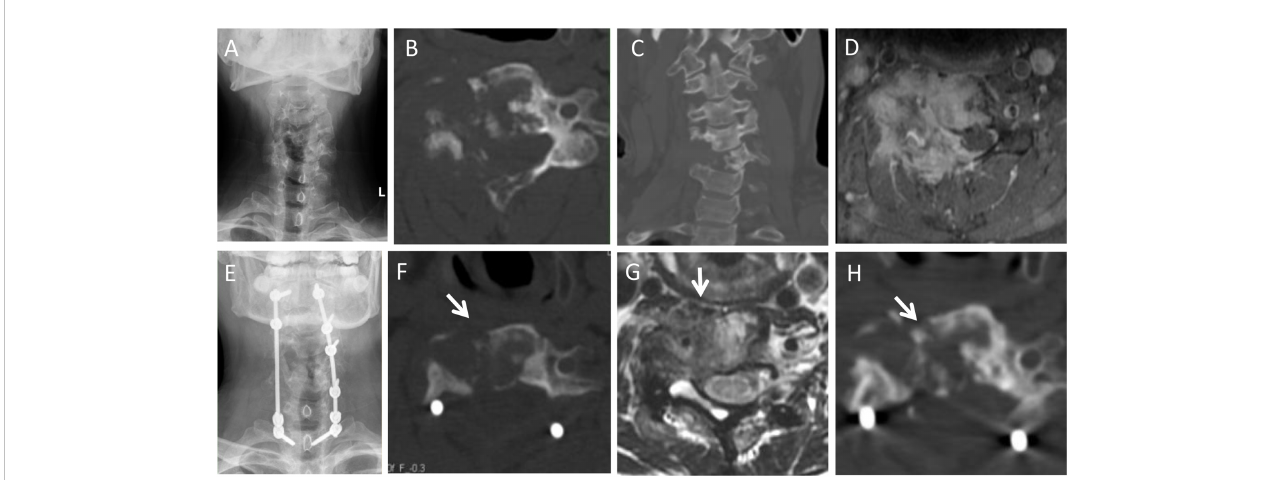
FIGURE 4 A 28-year-old male with neck pain for 12 months, worsened and accompanied with radiating pain in right upper extremity, shoulder and back, numbness in right hand for six months. Preoperative imaging examination showed a irregular and osteolytic lesion located in C4-6 with scoliosis. GTR was panned, but he underwent STR for strong adhesion between tumor and dural sac, which was revealed during the operation. CT and MRI scans revealed soft tissue mass and osteolytic lesion of local progression at 3-month follow-up after surgery (arrows in F,G ). He underwent radiotherapy. The lesion was stable with partial osteogenesis in 24-month follow-up after radiotherapy with new bone (arrow in H ). (A) : Preoperative X-ray; (B,C) : Preoperative axial and coronal CT scans; (D) : T1-weighted axial contrast enhanced MRI scan; (E) : Postoperative X-ray; (F) : Axial CT scan at 3-month follow-up after surgery; (G) : T2-weighted axial MRI scan in 3rd month after surgery; (H) : Axial CT scan at 24-month follow-up after radiotherapy.